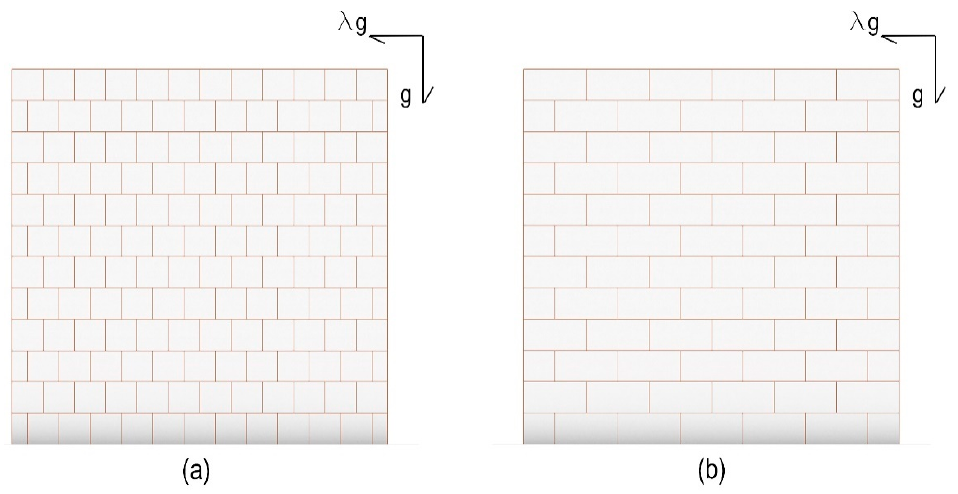
Figure 4. Geometry and load configurations: ( a ) m = 1; ( b ) m = 0.5.